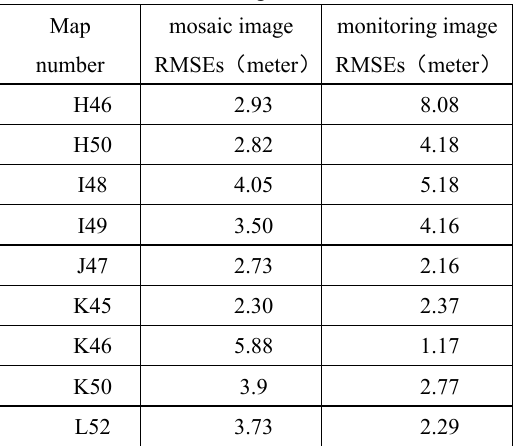
Table 5. Panchromatic image position accuracy